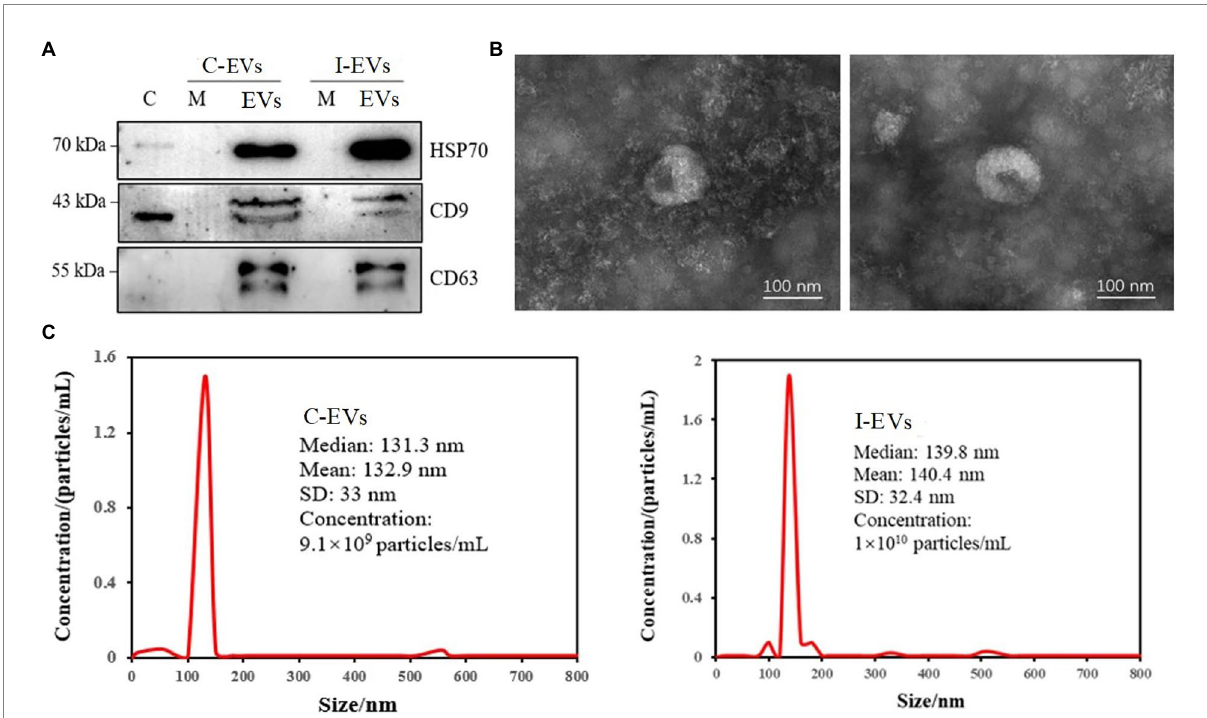
FIGURE 1 Characterization of the isolated extracellular vesicles. C-EVs denotes the extracellular vesicles produced by uninfected Henle-407 cells. I-EVs denotes the extracellular vesicles produced by Henle-407 cells infected with S. Typhimurium at 8 hpi. (A) Western blot analysis showing the specific presence of HSP70, CD63, and CD9 in the extracellular vesicles. C denotes the whole cell lysate, M denotes the cell culture medium, and EVs denotes the extracellular vesicles of Henle-407 cells. (B) Extracellular vesicles obtained from uninfected (left) and S. Typhimurium-infected (right) Henle-407 cells were visualized by transmission electron microscopy. (C) Size distribution of the obtained extracellular vesicles derived from uninfected (left) and S. Typhimurium-infected (right) Henle-407 cells. The mean size of the extracellular vesicles (nm) and their concentrations (number of particles/mL) were recorded using a nanoparticle tracking